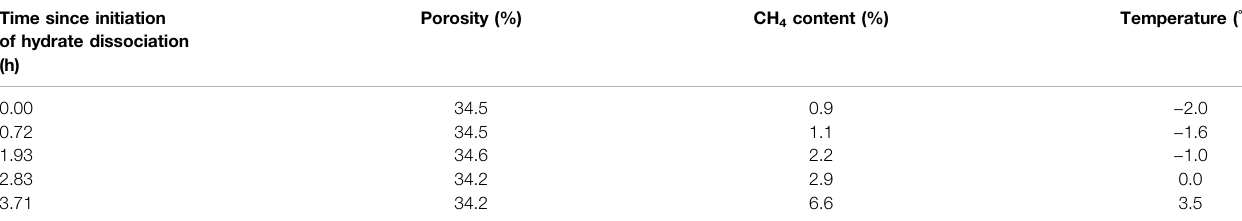
TABLE 2 | Details of scans analyzed from the hydrate dissociation experiment. Time since initiation of hydrate dissociation